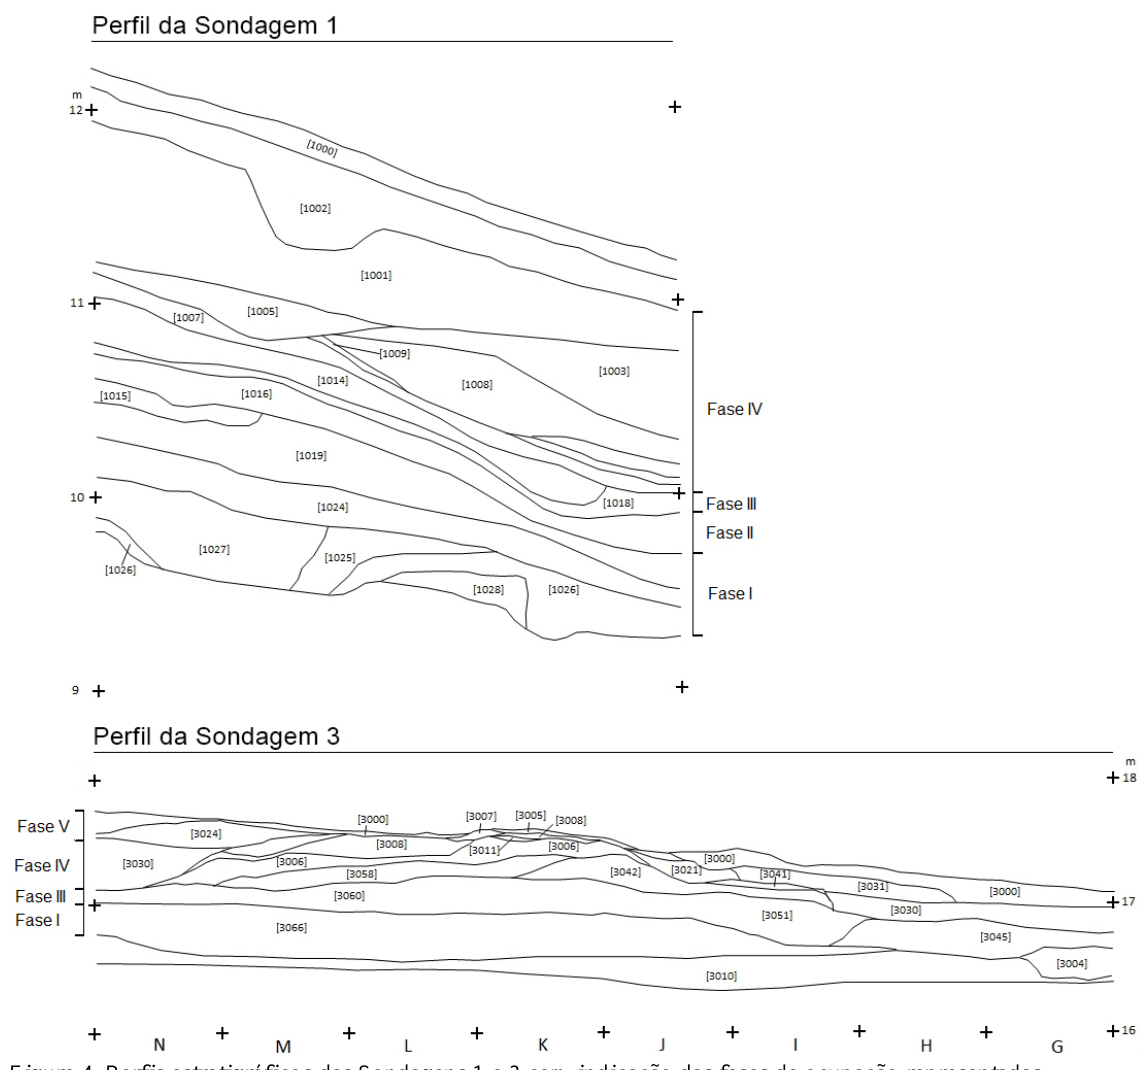
Figura 4. Perfis estratigráficos das Sondagens 1 e 3 com indicação das fases de ocupação representadas. Figure 4. Stratigraphic profiles of Tests 1 and 3 with indication of the represented occupation